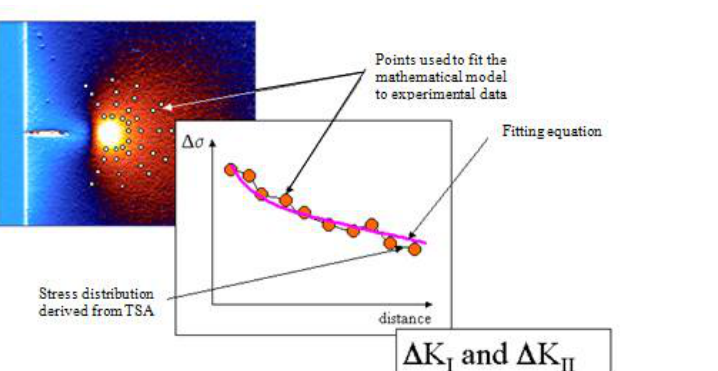
Figure 4: Schematic illustration of the methodology for calculating the stress intensity factor from thermoelastic data. E XPERIMENTAL SET -